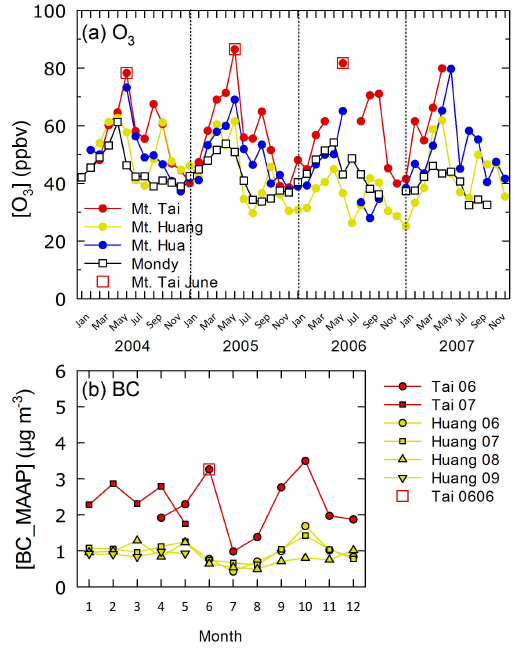
Fig. 5. Year-round observations of (a) O 3 and (b) BC at Mt. Tai and other mountain sites. Data for Mt. Tai in June are surrounded by squares.